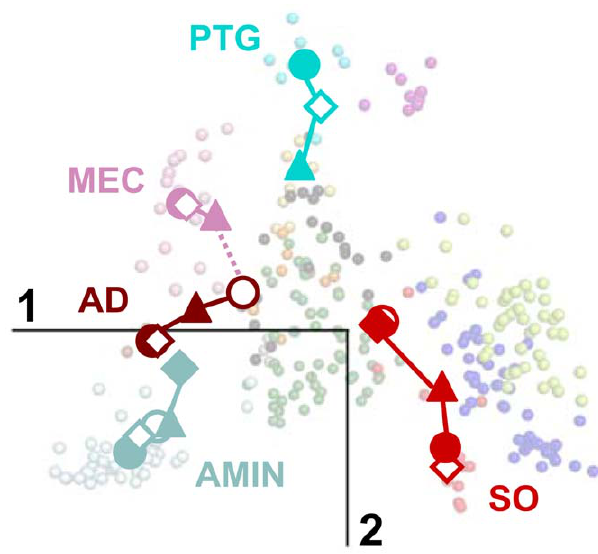
Figure 5. Evolutionary drift of specific sub-families. The barycenters of the SO (red), AMIN (light blue), AD (brown), MEC (pink) and PTG (cyan) sub-families are projected onto the plane formed by the first two components of the human active space. The symbol code indicates the species ( N. vectensis : closed diamonds, C. elegans : open circles; C. intestinalis : closed triangles; D. rerio : open diamonds ; H. sapiens : closed circles). The color lines joining the barycenters are given for clarity purpose. The pink dashed line indicates the putative phylogenetic relationship between AD and MEC receptors. Transparent circles represent human elements, with color code referring to the GPCR sub-families (AD: brown; AMIN: light blue; CHEM: dark blue; LGR: yellow; MEC: pink; MTN: grey; MRG: violet; OPN: orange; PEP: dark green; PTG: cyan; PUR: light green; SO: red; UC: black).